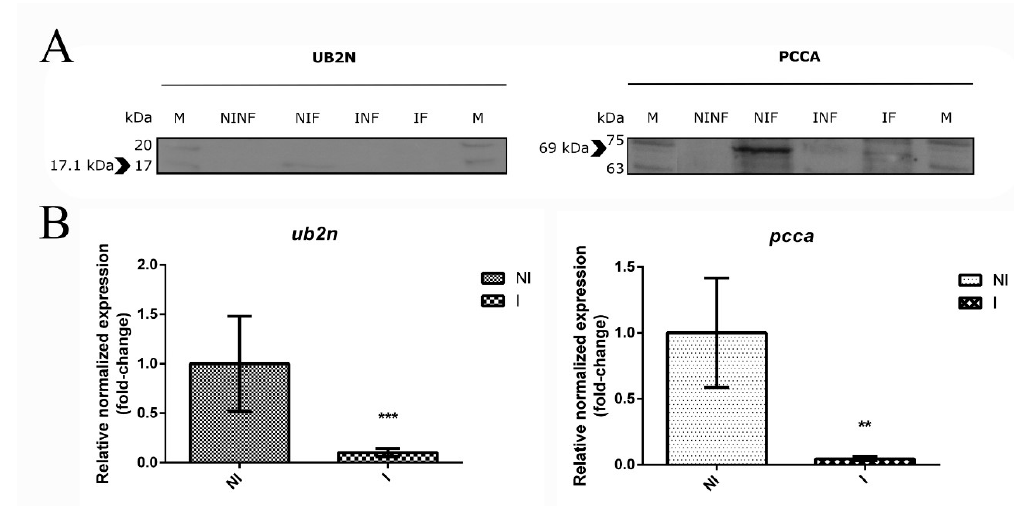
Figure 6. Protein representation and gene expression of selected targets. ( A ) Western blot of UB2N and PCCA. Protein extracts from salivary glands exposed to different conditions were used to validate the protein representation of UB2N and PCCA by using mouse serum (1:200) and a hybridoma supernatant (without dilution), respectively. Arrows indicate the molecular size of the target. M: molecular weight, NZYColour Protein Marker II, NZYTech. NINF: uninfected unfed. NIF: uninfected fed. INF: infected unfed. IF: infected fed. Exposure and contrast parameters were not modified. The full-length blots are displayed in Supplementary Figure S5. ( B ) Relative expressions of ub2n and pcca were evaluated in fed uninfected and fed B. ovis infected salivary glands of R. bursa using qPCR. Data was normalized using 16S rRNA, elongation factor , and β -tubulin reference genes. The expression of fed uninfected group (control) is set to 1 for a better interpretation. NI: fed uninfected group. I: fed infected group. Statistical analysis were conducted using the Pfaff method. Significance is represented by ** p < 0.01, *** p < 0.001.